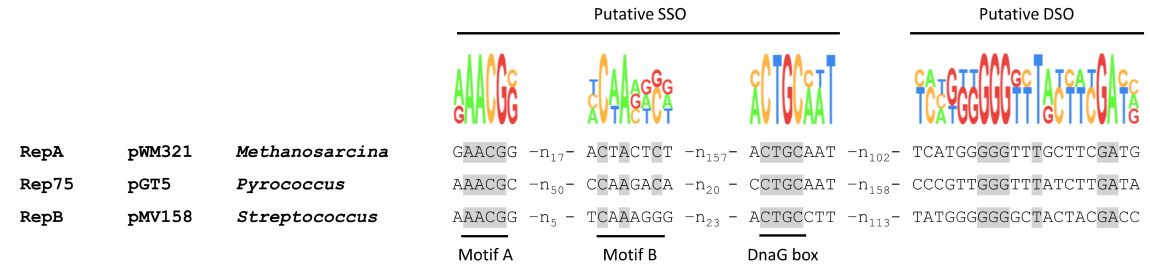
Figure 6. Identification of putative pWM321 and pRS1595 double-strand origin and single-strand origin. Alignment of the sequence of the putative DSO and SSO of RepA from pWM321 and pRS1595 with the according sequence of Rep75 from the archaeal plasmid pGT5 from Pyrococcus abyssi [16] and of RepB from the bacterial plasmid pMV158 from Streptococcus agalactiae [24]. Putative motifs A, B and the DnaG box as primase binding site of bacterial phages and plasmids are indicated in the SSO. The DSO consists of just one motif, 100–200 nucleotides downstream of the SSO. Conserved nucleotides are shaded